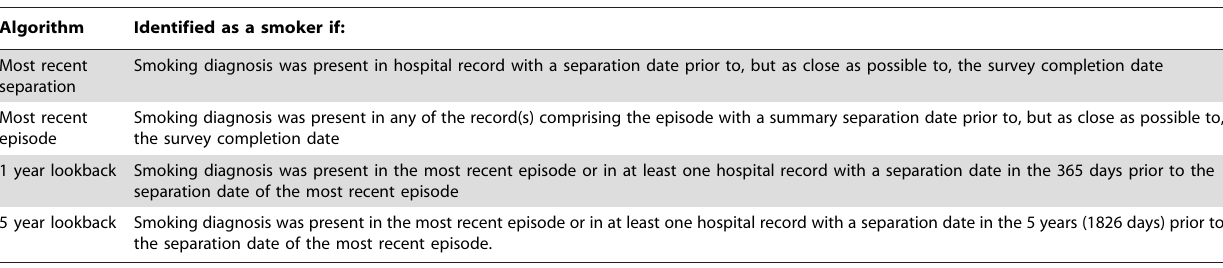
Table 1. Algorithms for identifying smokers from hospital data.